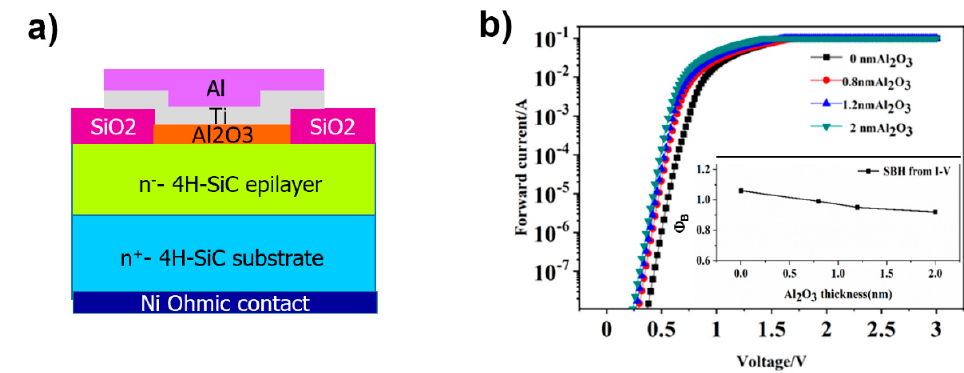
Figure 11. ( a ) Schematic view of a Ti/4H-Si Schottky diode with the insertion of an ultrathin Al 2 O 3 layer between metal and semiconductor surface. ( b ) Forward I–V characteristics of the Ti/4H-SiC Schottky contact with increasing thickness of the inserted Al 2 O 3 -layer (0, 0.8, 1.2 and 2 nm). The trend of the Schottky barrier height as function of Al 2 O 3 thickness is reported in the inset. Panel ( b ) is adapted with permission from Ref. [86]. Copyright 2021 Elsevier Ltd.